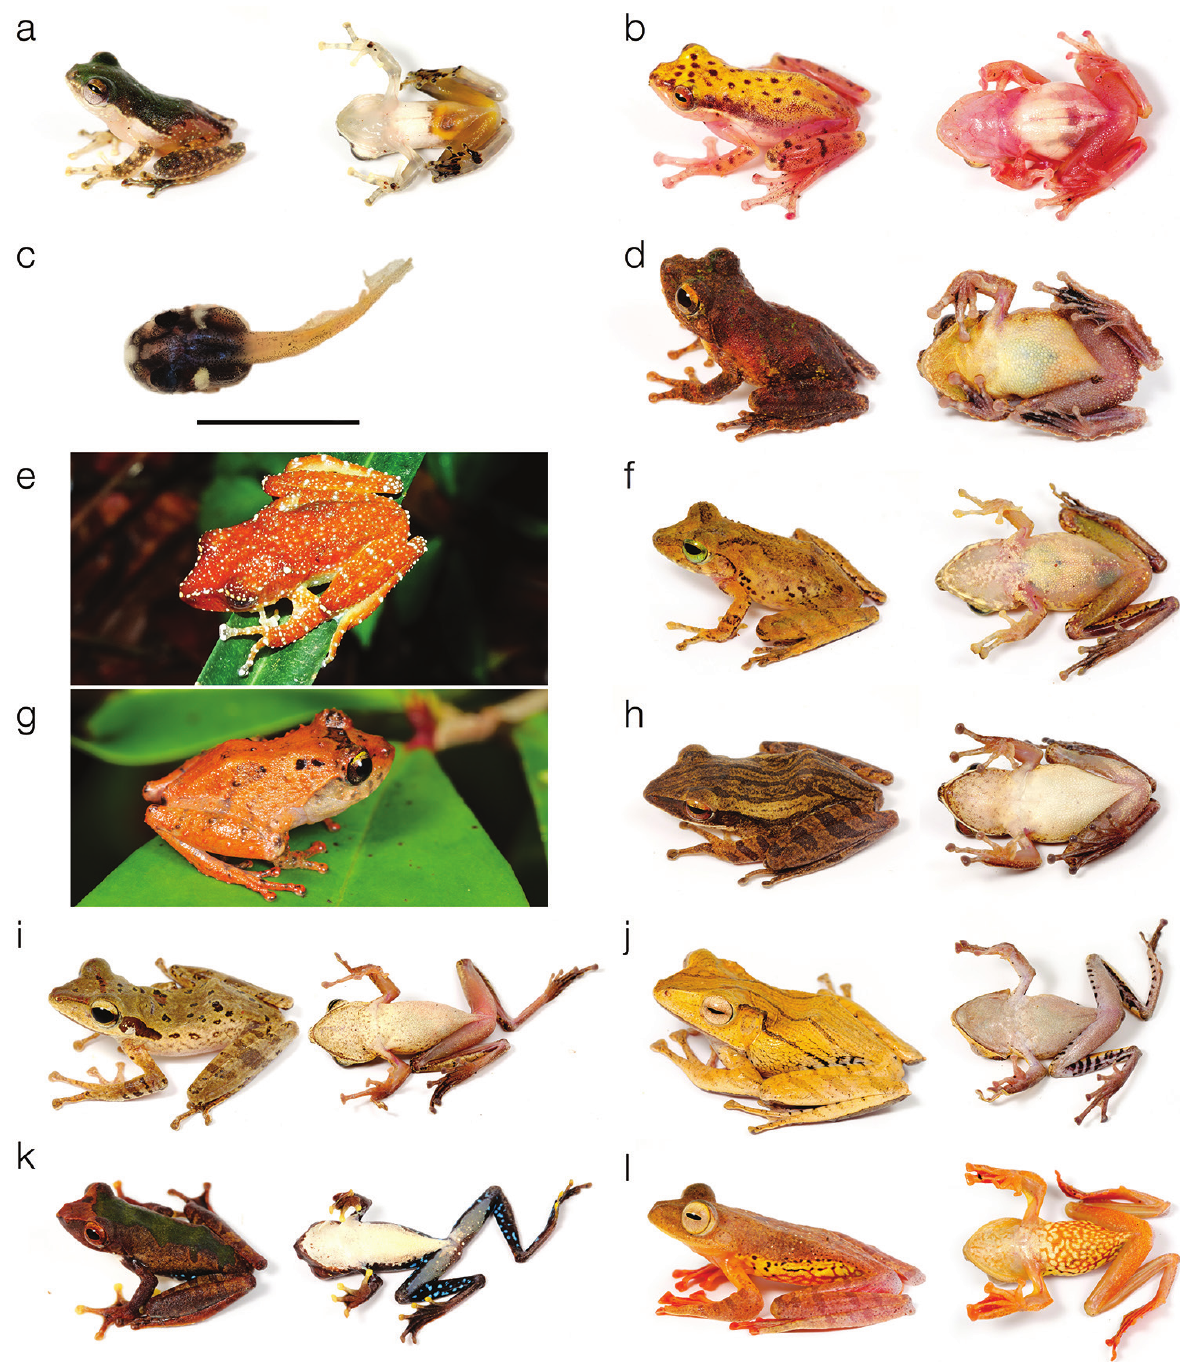
Figure 5. Rhacophorid frogs at MBCA: a , Feihyla kajau ; b , Chiromantis inexpectatus ; c , Chiromantis inexpectatus tadpole, scale: 5 mm; d , Kurixalus appendiculatus ; e , Nyctixalus pictus (photo voucher only); f , Philautus hosii ; g , Philautus nephophilus ; h , Polype- dates leucomystax ; i , Polypedates macrotis ; j , Polypedates otilophus ; k , Rhacophorus cyanopunctatus ; l , Rhacophorus pardalis. Pairs of photos (dorsolateral and ventral) depict the same individual.